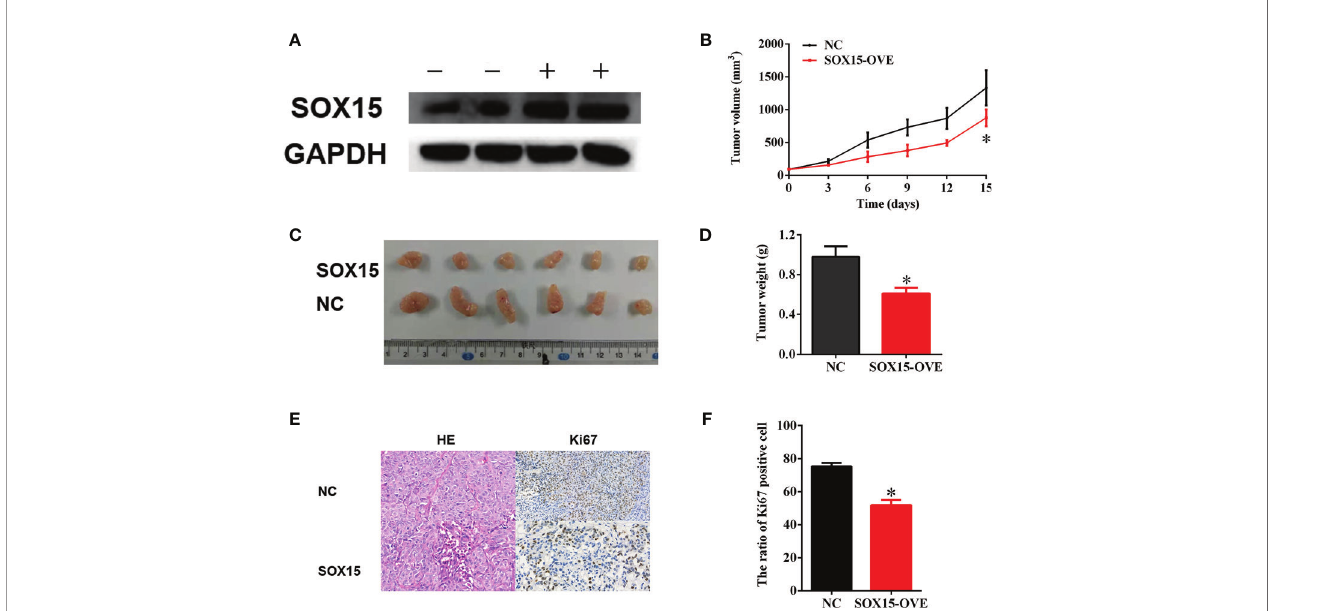
FIGURE 6 | Sox15 inhibits in vivo HCC tumorigenicity. (A) The overexpression ef fi ciency of Sox15 within the HCC cells as measured through the WB assay. (B) The tumor growth curve in nudemice. (C, D) Thetypical image and tumor weight of Sox15-transfected and vector-transfected tumors at the time of sacri fi ce. (E, F) Classic HE and Ki67 IHC of tumor samples and quanti fi cation. *p < 0.05.